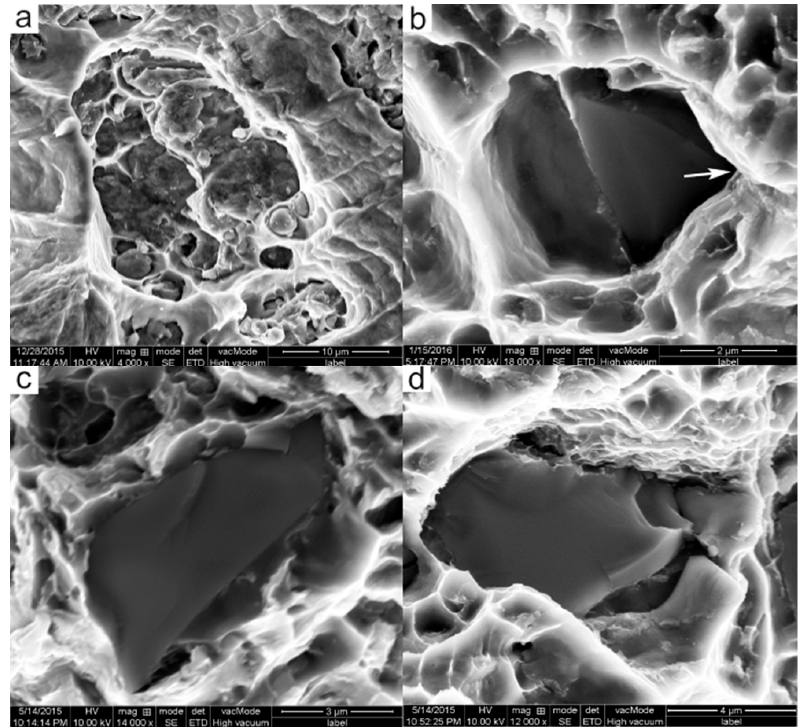
Figure 8. Typical SEM fractographs of the PTF-SiC p /6061Al composite. ( a ) fracture across the matrix; ( b ) debonding of the SiC p /matrix interface; ( c , d ) fragmentation of the SiC p .